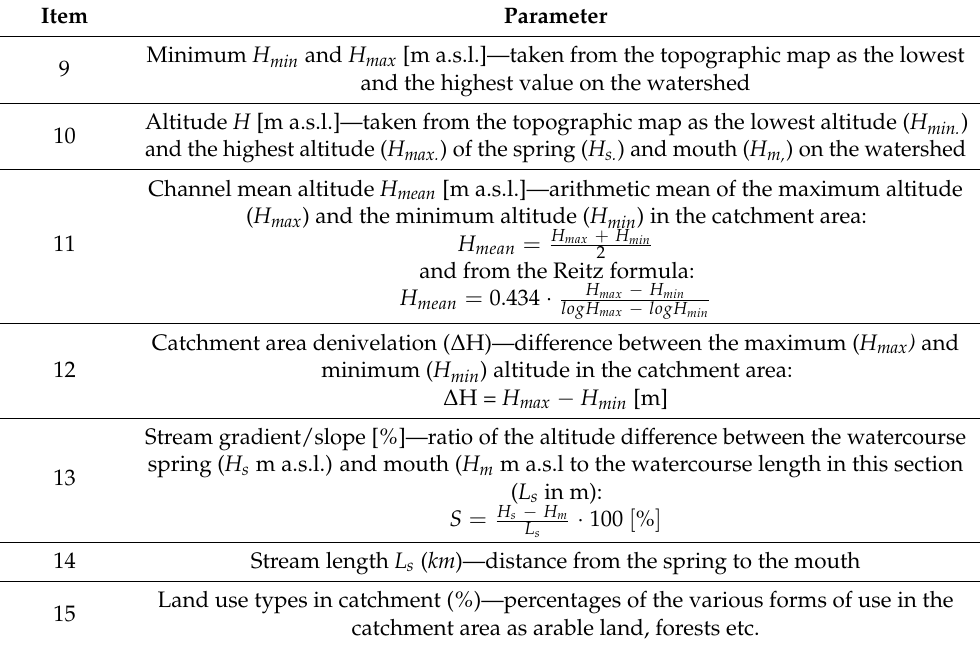
Table 2. Cont. Item Parameter Minimum H min and H max [m a.s.l.]—taken from the topographic map as the lowest and the highest value on the